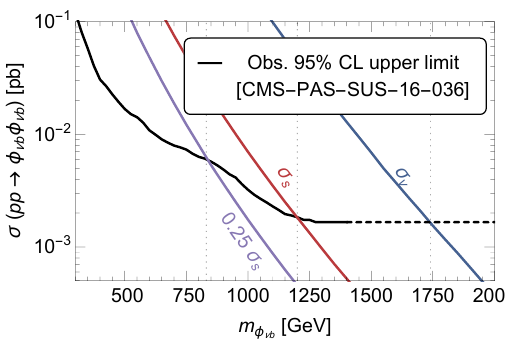
Figure 9 . Bounds on scalar and vector MLQs that decay into ( (cid:23)b )( (cid:23)b ) (cid:12)nal states. The observed 95% CL upper limit on the production cross section (black solid line) is taken from sbottom searches